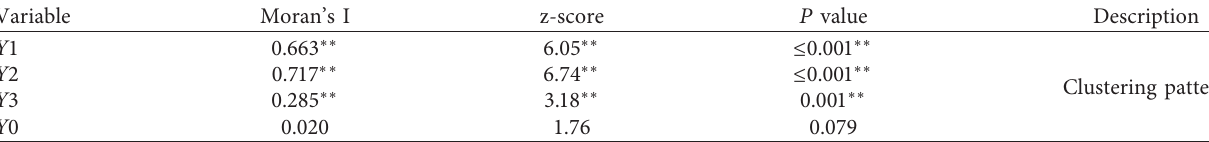
Table 6: Results of the global autocorrelation analysis of urban resilience.